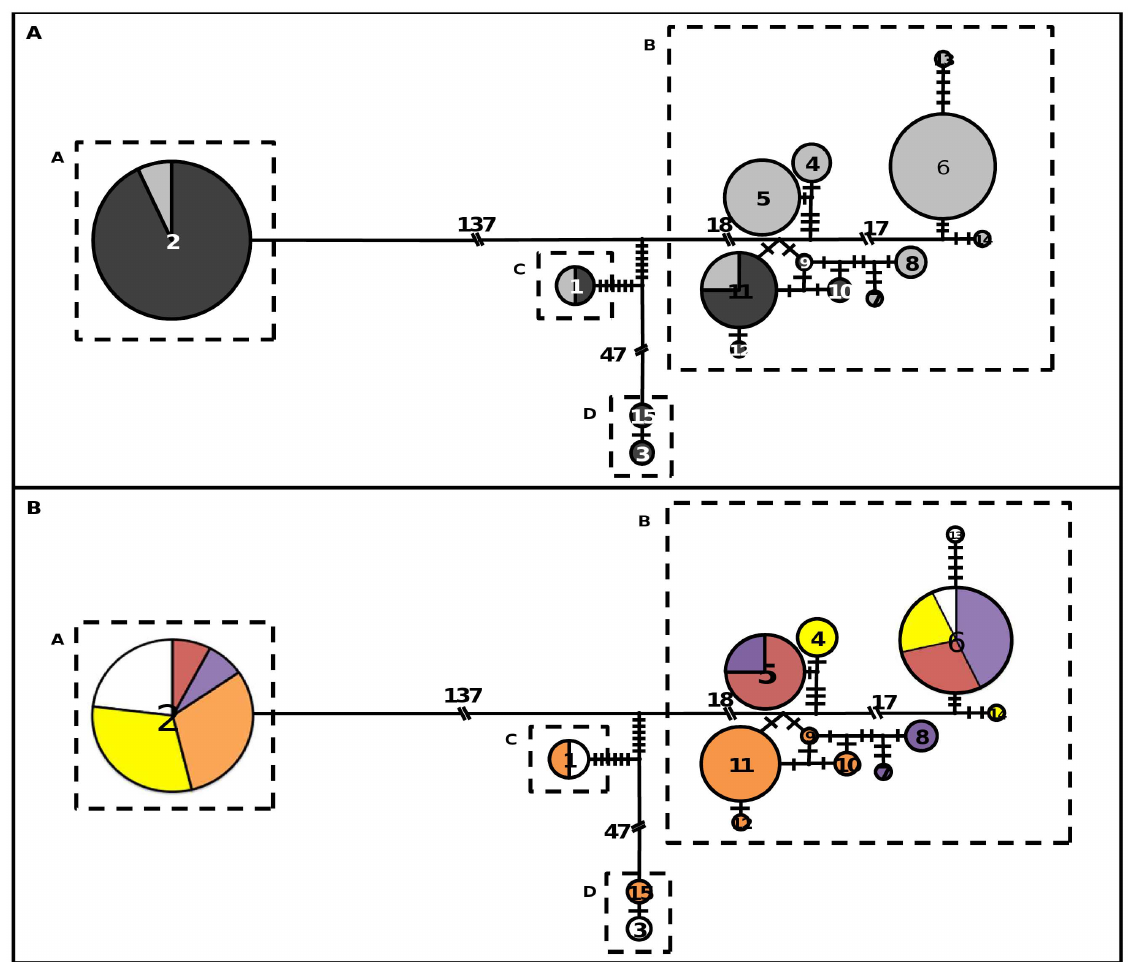
Figure 6. Median joining network derived from reconstructed DNA sequence haplotype of CRTISO gene. Haplotypes are displayed at network nodes and are symbolised by circles whose diameter is proportional to the frequency in the sample. The code number of the haplotypes is written in the circle centre. Perpendicular hashes on the lines joining haplotypes represent substitutions. When too numerous, they are displayed as slanting hashes with the number of substitutions differentiating two network nodes. The main clusters are identified by dotted boxes. (A) The black and grey proportions of each circle represent respectively the proportion of individuals from the Western and Eastern genetic groups (estimated by STRUCTURE analysis) sharing the same haplotype. (B) Colours represent the proportion of different colour groups: white, yellow, orange, red and purple.